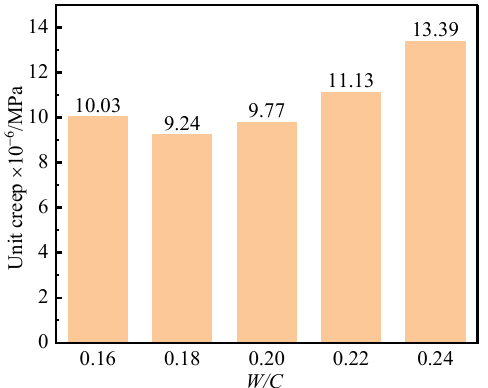
Figure 5. Unit creep of the UHPC cured for 90 d with different W/C